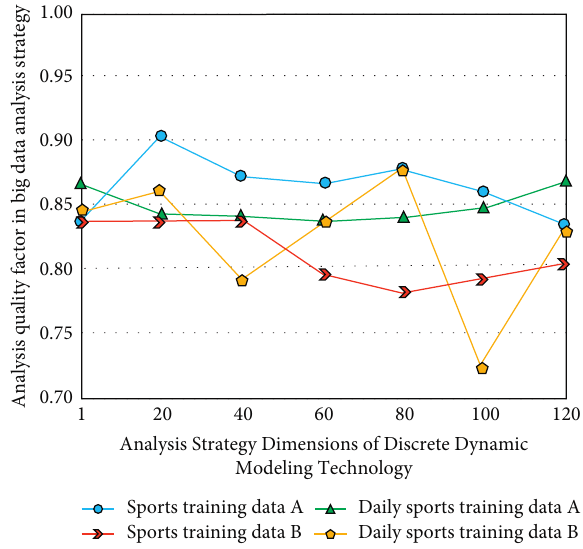
Figure 4: The relationship between different dimensions of analysis strategies and analysis quality factors under big data analysis